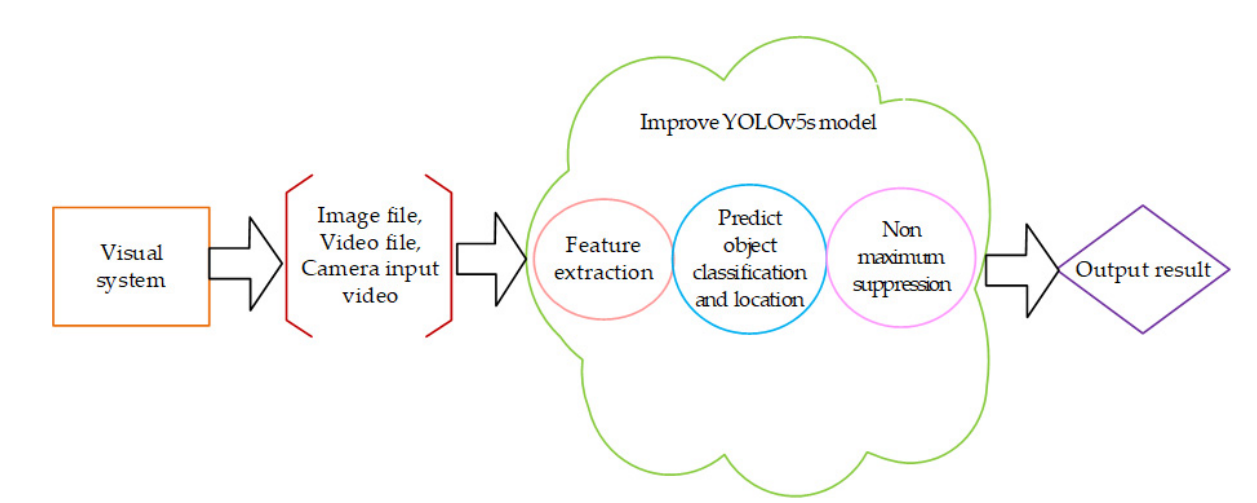
Figure 3. Vision system inspection process.